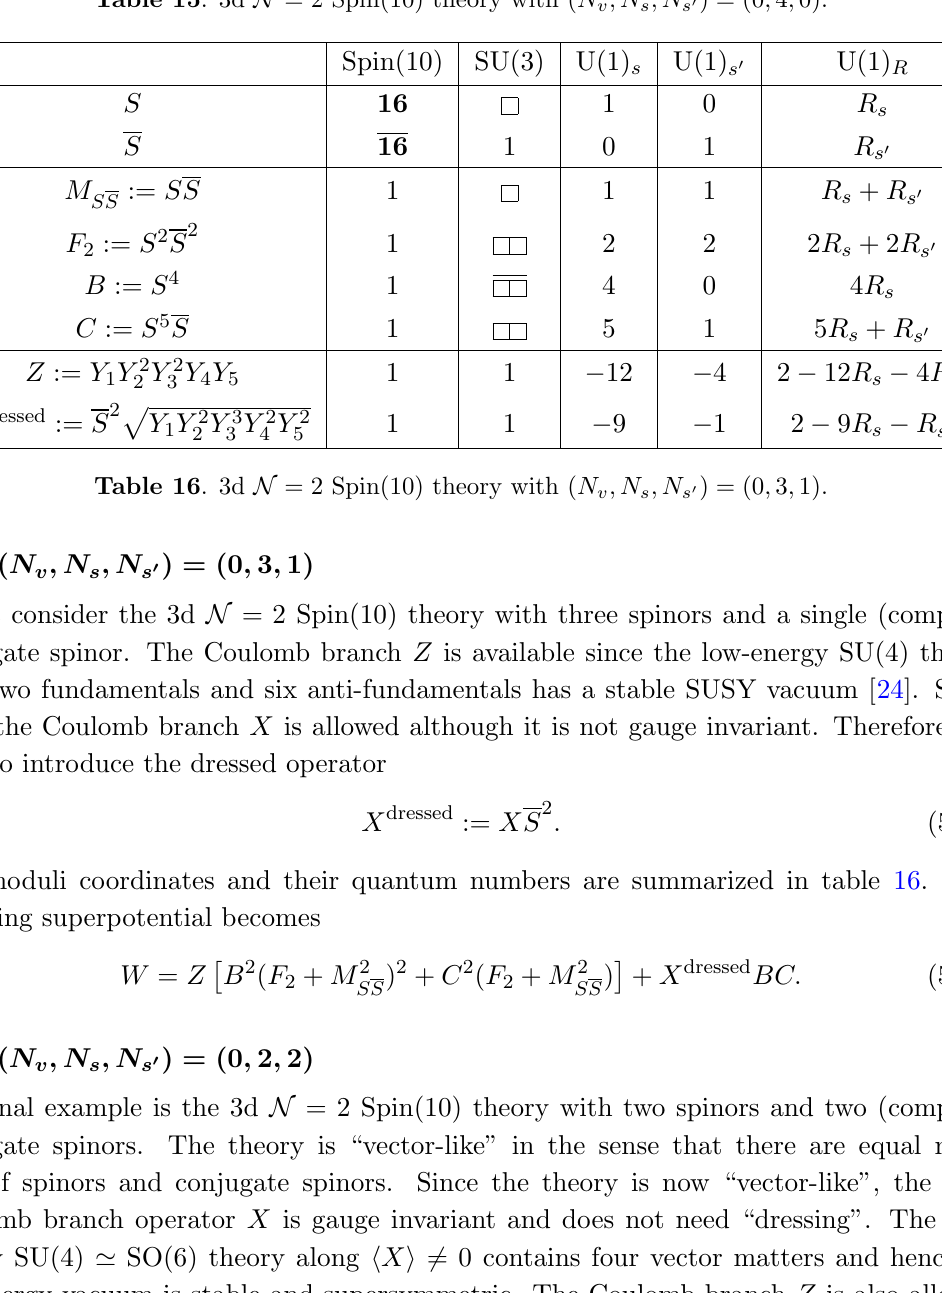
Table 15 . 3d N = 2 Spin(10) theory with ( N v ; N s ; N s 0 ) = (0 ; 4 ; 0).